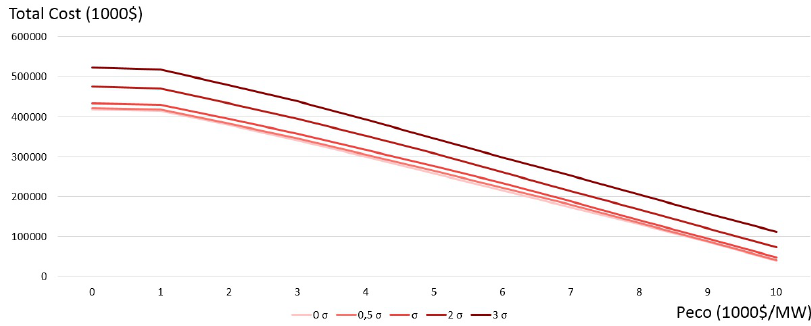
Figure 10. Variation of the total cost with respect to P eco and σ (own